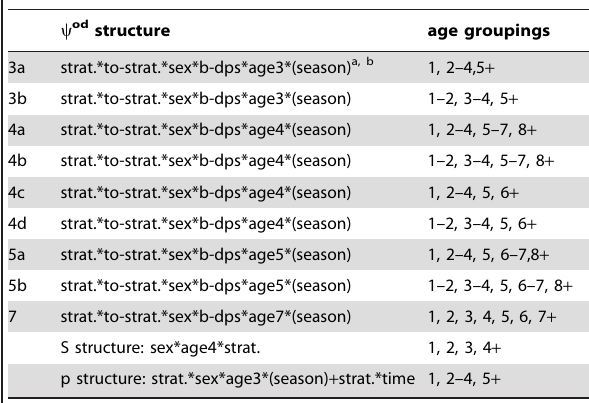
*Abbreviations for origin and destination areas are: E=EDPS, W=WDPS, n=northern (EDPS), s=southern (EDPS). In the Y od , the first superscript represents the natal DPS (or sub-DPS) and the second superscript represents the destination DPS. **Values indicate the best model based on AICc (see Table 2); if more than one model is listed, model averaging was used with models in the order listed, with model weights in brackets.